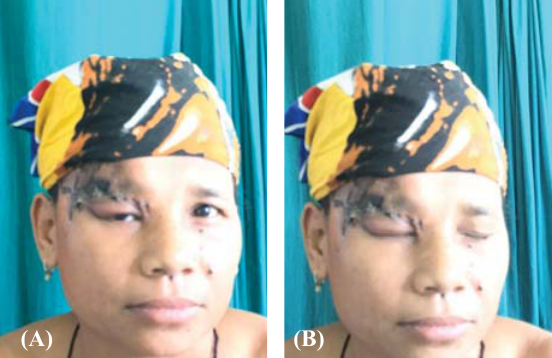
Figure 5. One-month follow-up pictures showing elated patient after complete excision of mass with right supraorbital incisional scar with patchy areas of hyperpigmentation and skin necrosis. She is able to (A) open and (B) close her right